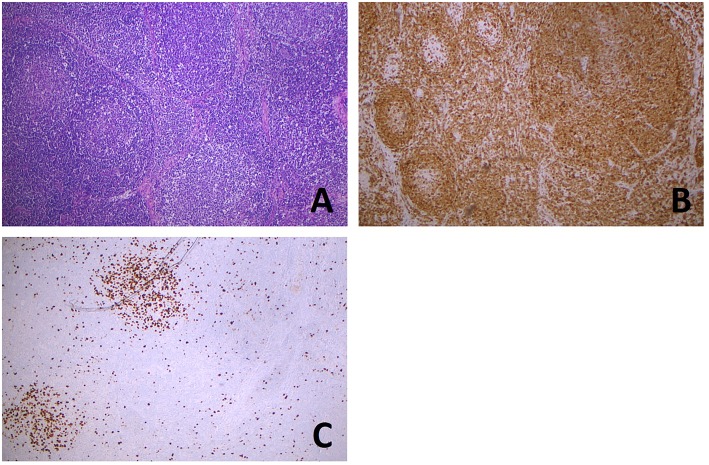
Partial involvement of lymph node by FL. Hematoxylin and eosin stain (A) shows the coexistence, in the same lymph node slide, of normal lymphoid follicles (left), with well-defined mantels and hyperplastic germinal centers, with a low grade follicular lymphoma (right) showing irregularly shaped and confluent neoplastic follicles. BCL2 immunostaining (B) is negative in hyperplastic germinal centers (left) and positive in a large neoplastic center (right). Ki67 proliferative index (C) is high in hyperplastic centers (left and top), whereas in the neoplastic proliferation it is very low (right and bottom). (All images, original magnification x50).